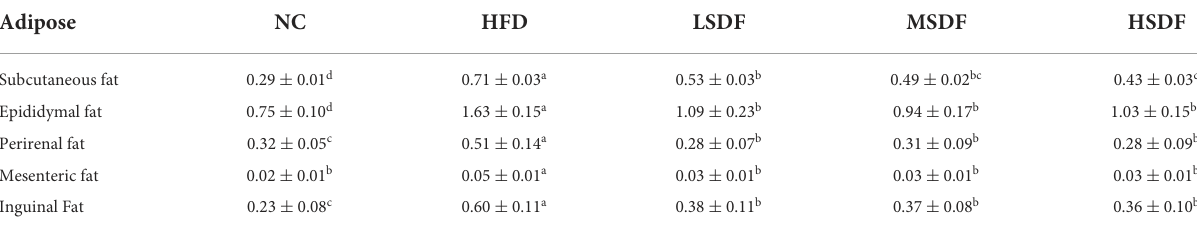
TABLE 1 Effects of the PP-SDF on the relative masses of adipose tissue of mice.